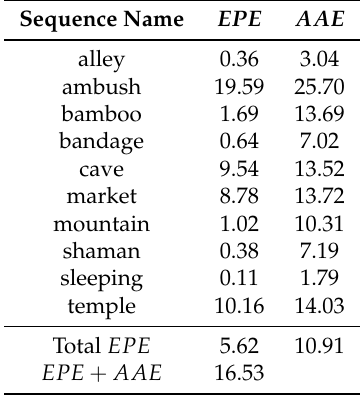
Table 12. Summary of results. The end point error and average angular error obtained by random locations in the MPI-Sintel training